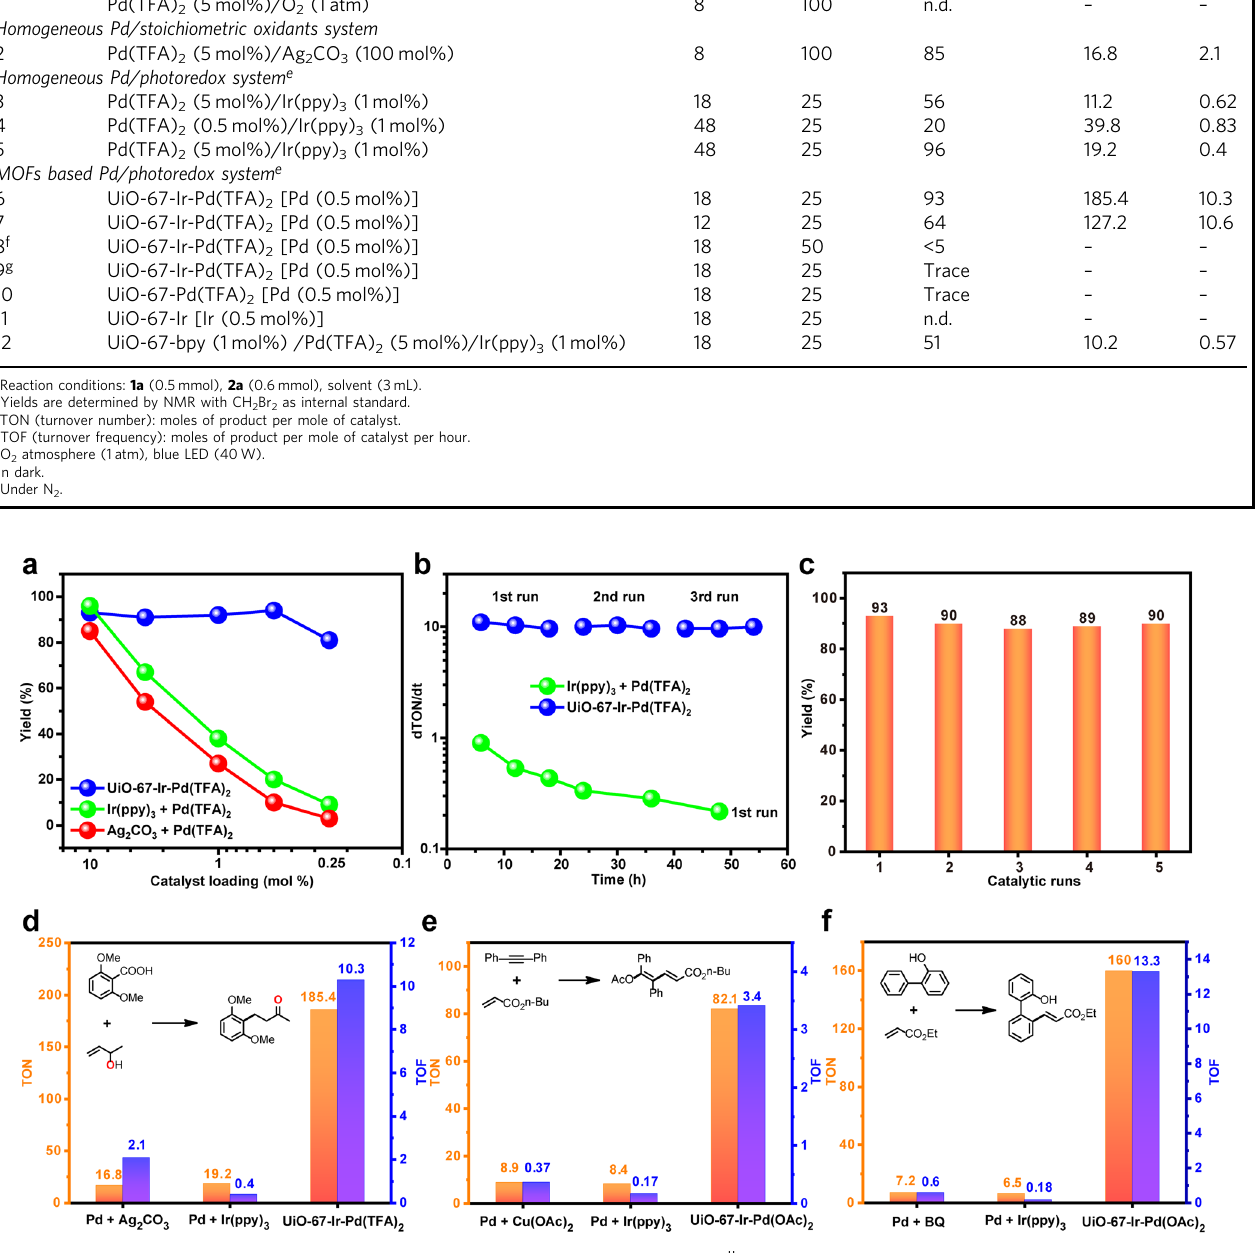
Fig. 4 Activity and recyclability of the selected catalysts. a Plots of yields for 3a vs Pd II catalyst loading of UiO-67-Pd(TFA) 2 and the homogeneous systems under their respective optimized reaction conditions. b the kinetic rates of UiO-67-Ir-Pd(TFA) 2 and homogenous mixed system. c recyclability tests of UiO-67-Ir-Pd(TFA) 2 in the decarboxylative coupling between 1a and 2a . TON and TOF values of UiO-67-Pd X 2 and the homogeneous systems under their respective optimized reaction conditions for d decarboxylative coupling, e acetoxypalladation of alkynes with alkenes, f C − H alkenylation of